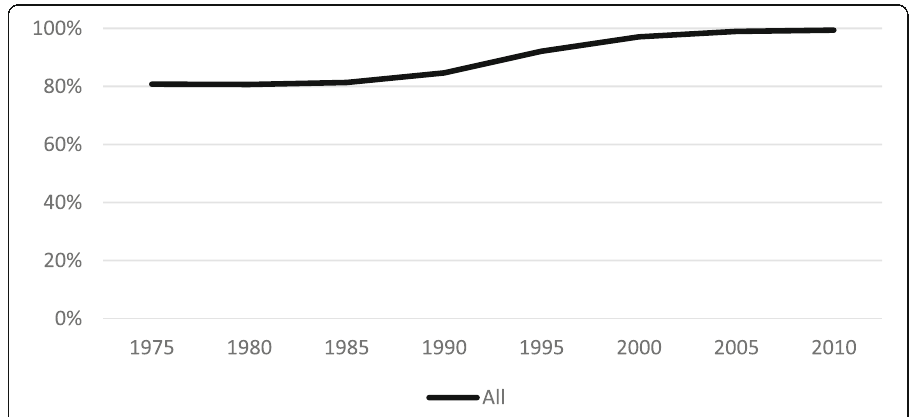
Fig. 1 Evolution of visa restrictiveness in European countries for nationals from African countries* (1973 – 2010). Source: DEMIG VISA database. Computation method: a yearly index is calculated by computing the percentage of African countries that need a travel visa to enter a destination country in Europe. The average value for all destination and origin countries within the region of interest for every year was subsequently